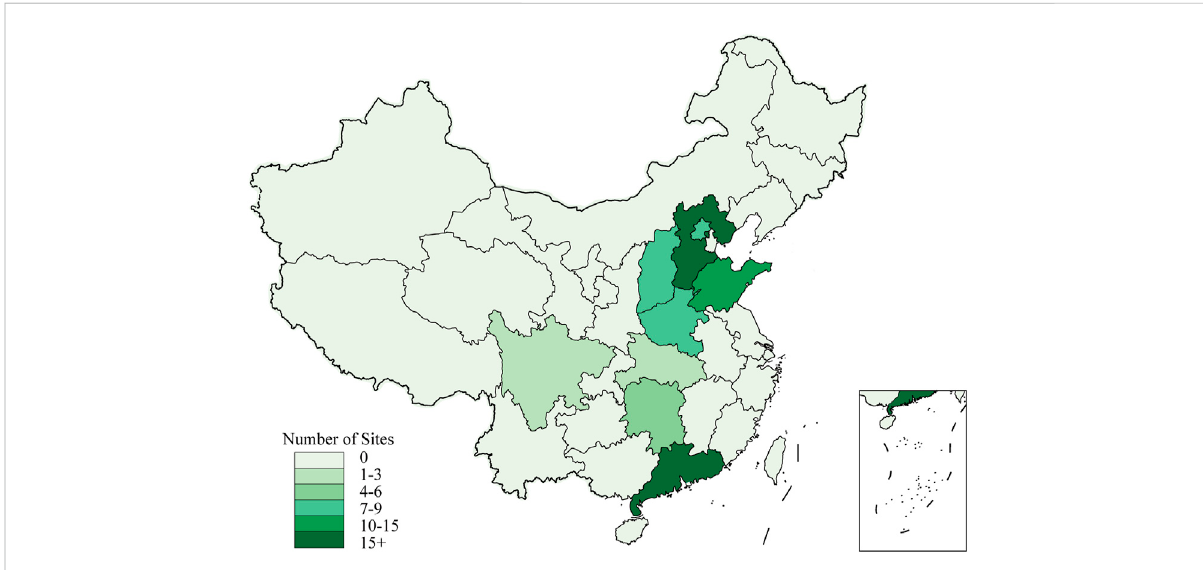
FIGURE 2 Sites distribution of the VENUS